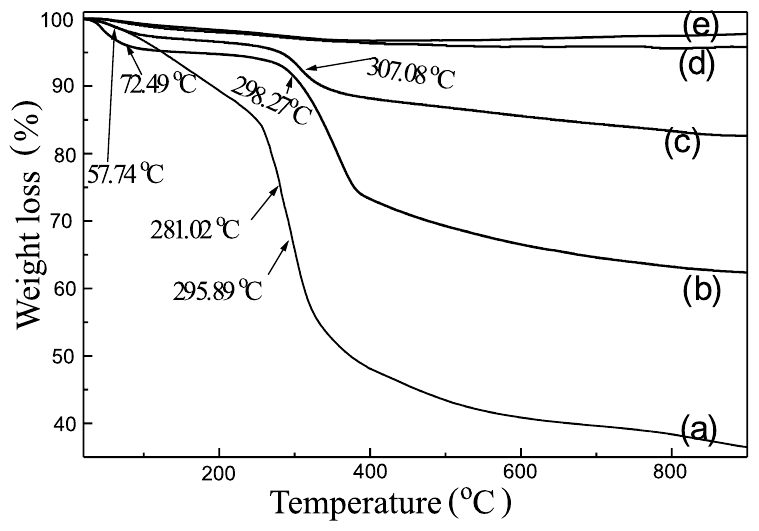
Fig. 4 – Thermographs from sample of: (a) Chitosan, (b) composite I, (c) composite III, (d) HApIII, and (e) HAp100.